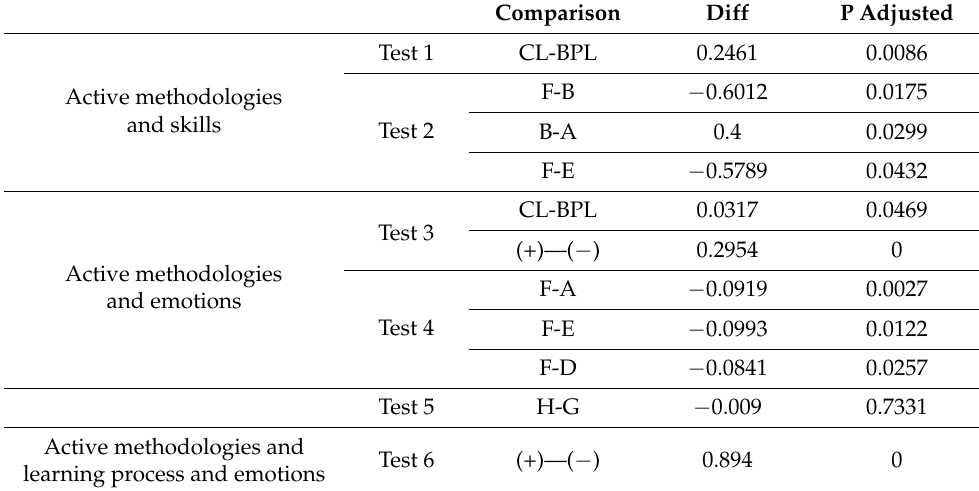
Table A4. Tukey’s SHD results.